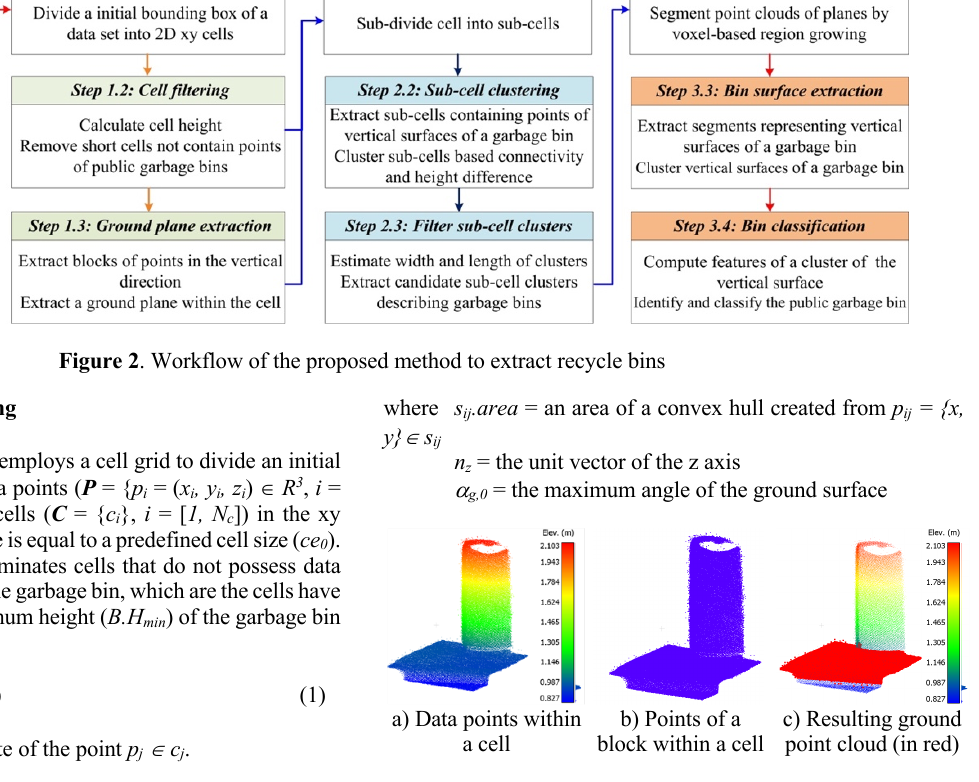
Figure 3 . Extracting ground points within a